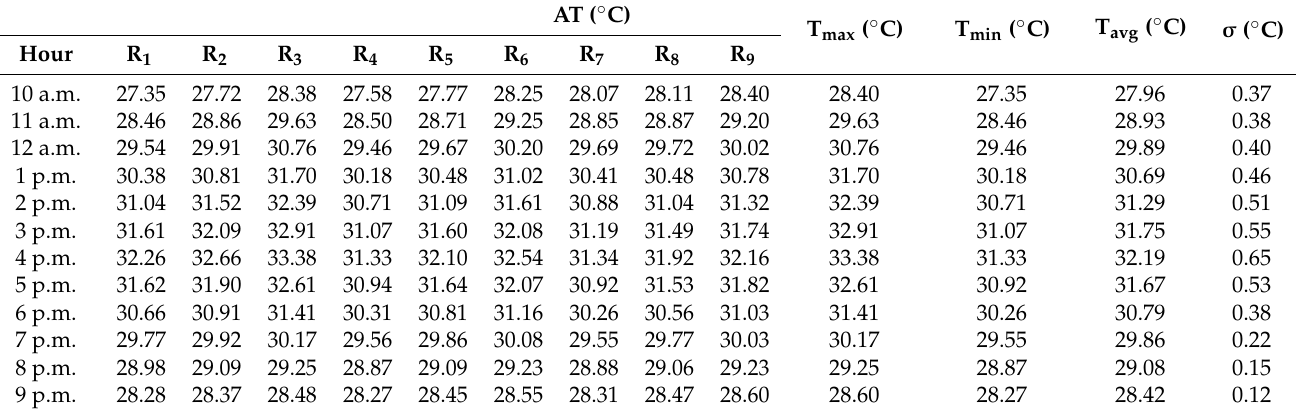
Table 4. Air temperature from 10:00 a.m. to 09:00 p.m. of 15 July 2021—Scenario AS. AT ( ◦ C)